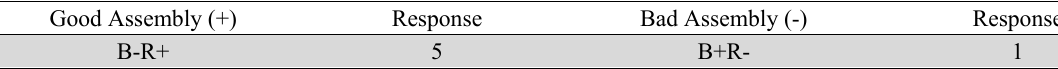
Response for Washer (B-R+, B+R-)